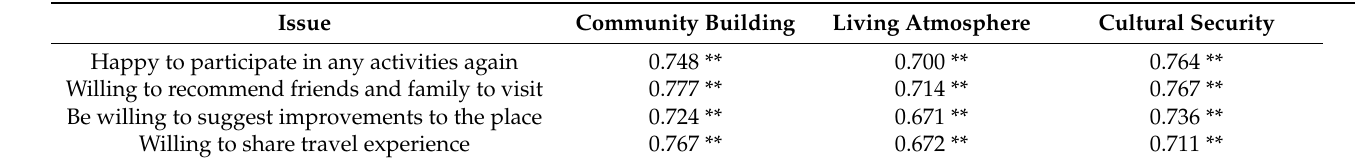
Table 8. Correlation analysis of society impact and re-tourism intention.